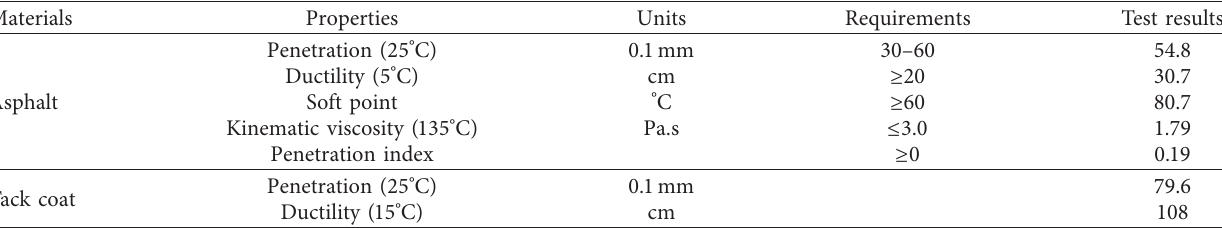
Table 2: Properties of asphalt binder and tack coat residue.